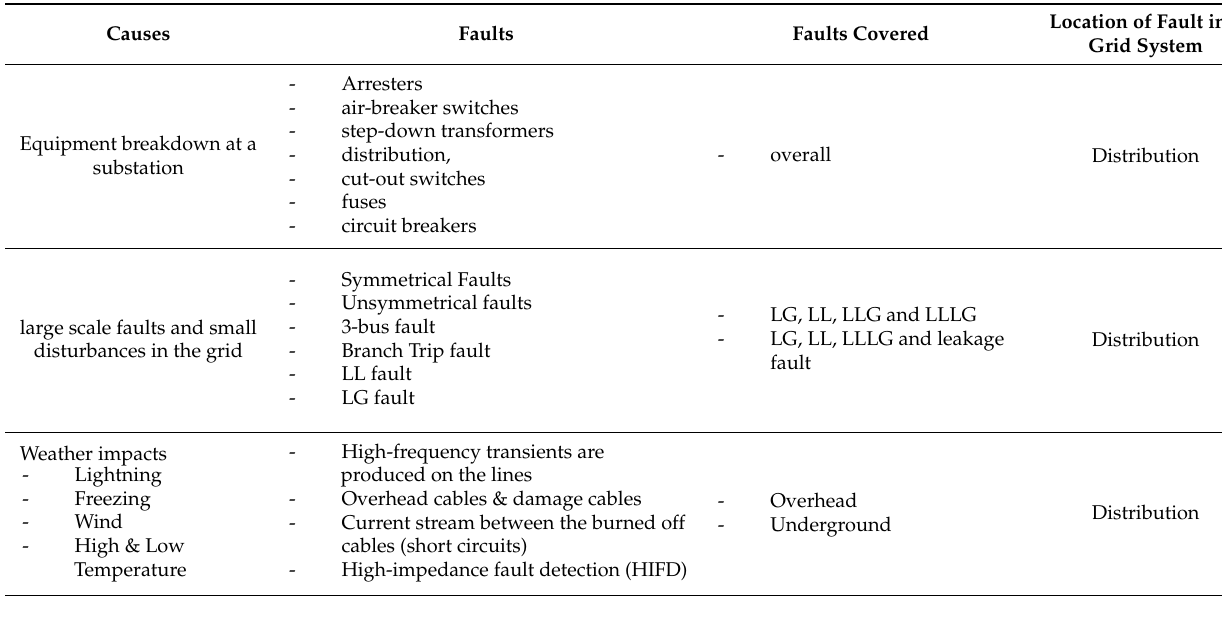
Table 2. List of statistical faults and